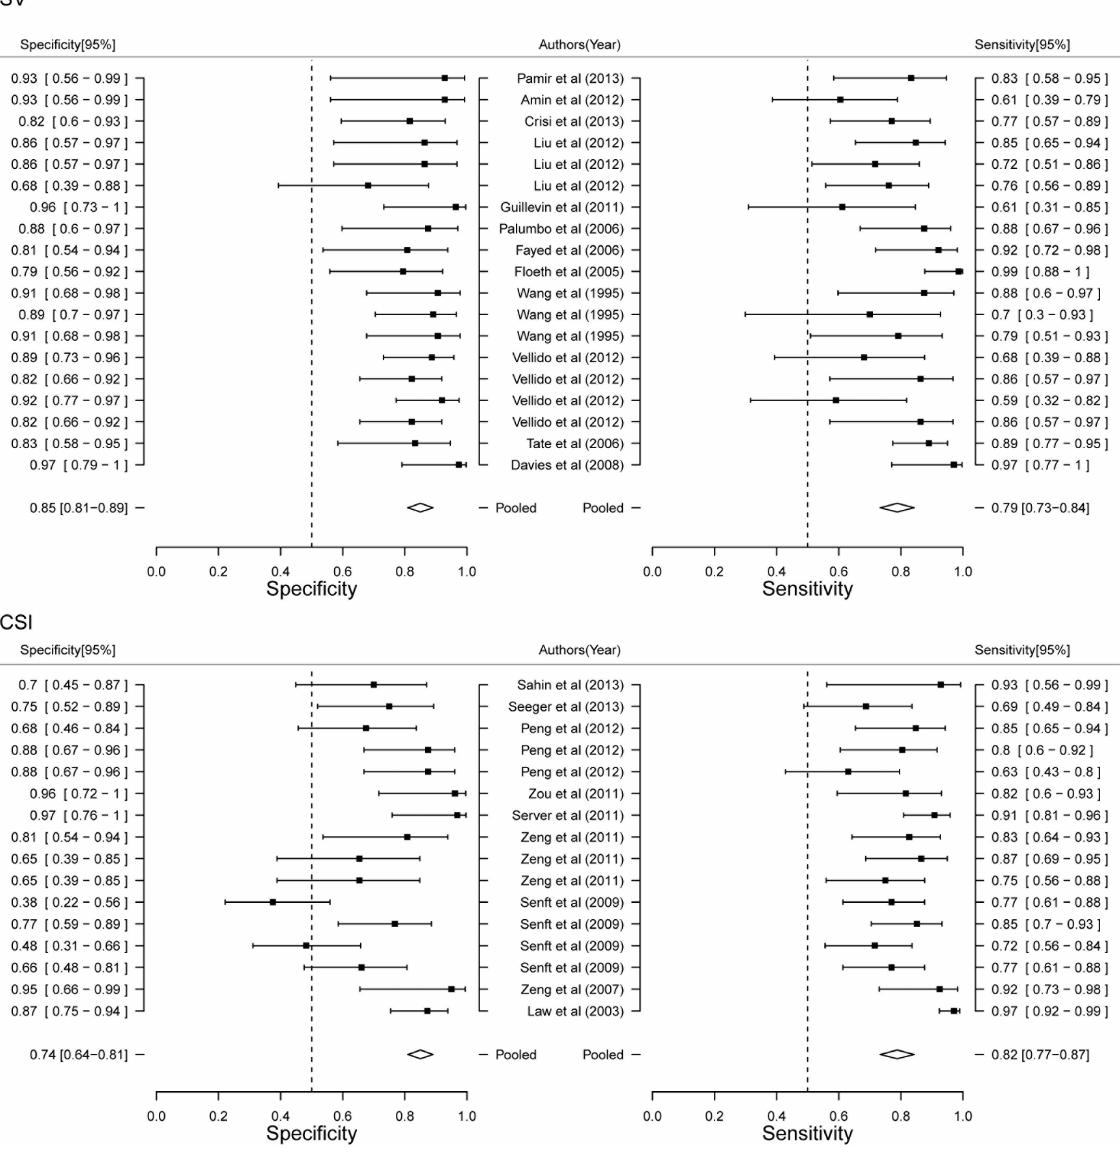
Figure 6. Forest plot of estimate of diagnostic accuracy of SV and CSI stratified meta-analysis.